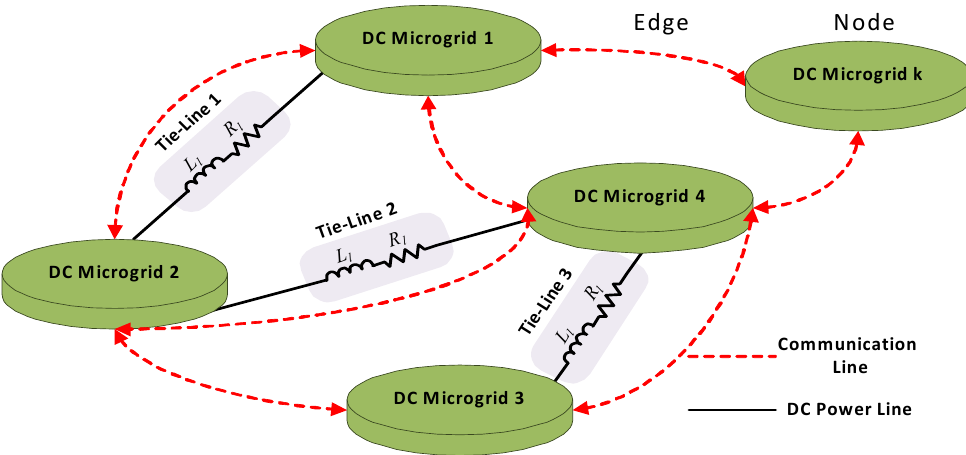
Figure 4. Communication Topology of DC MGs cluster [7].